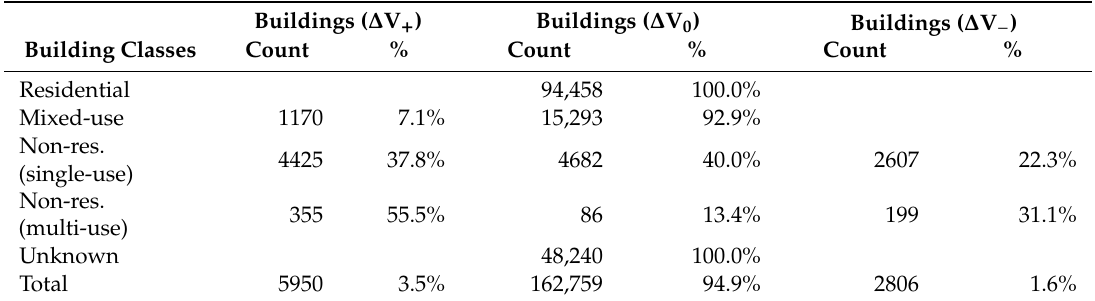
Table 2. Distribution of buildings according to the volume di ff erences between UsageZone volumes (from the Functiekaart) and buildings (from the city model).